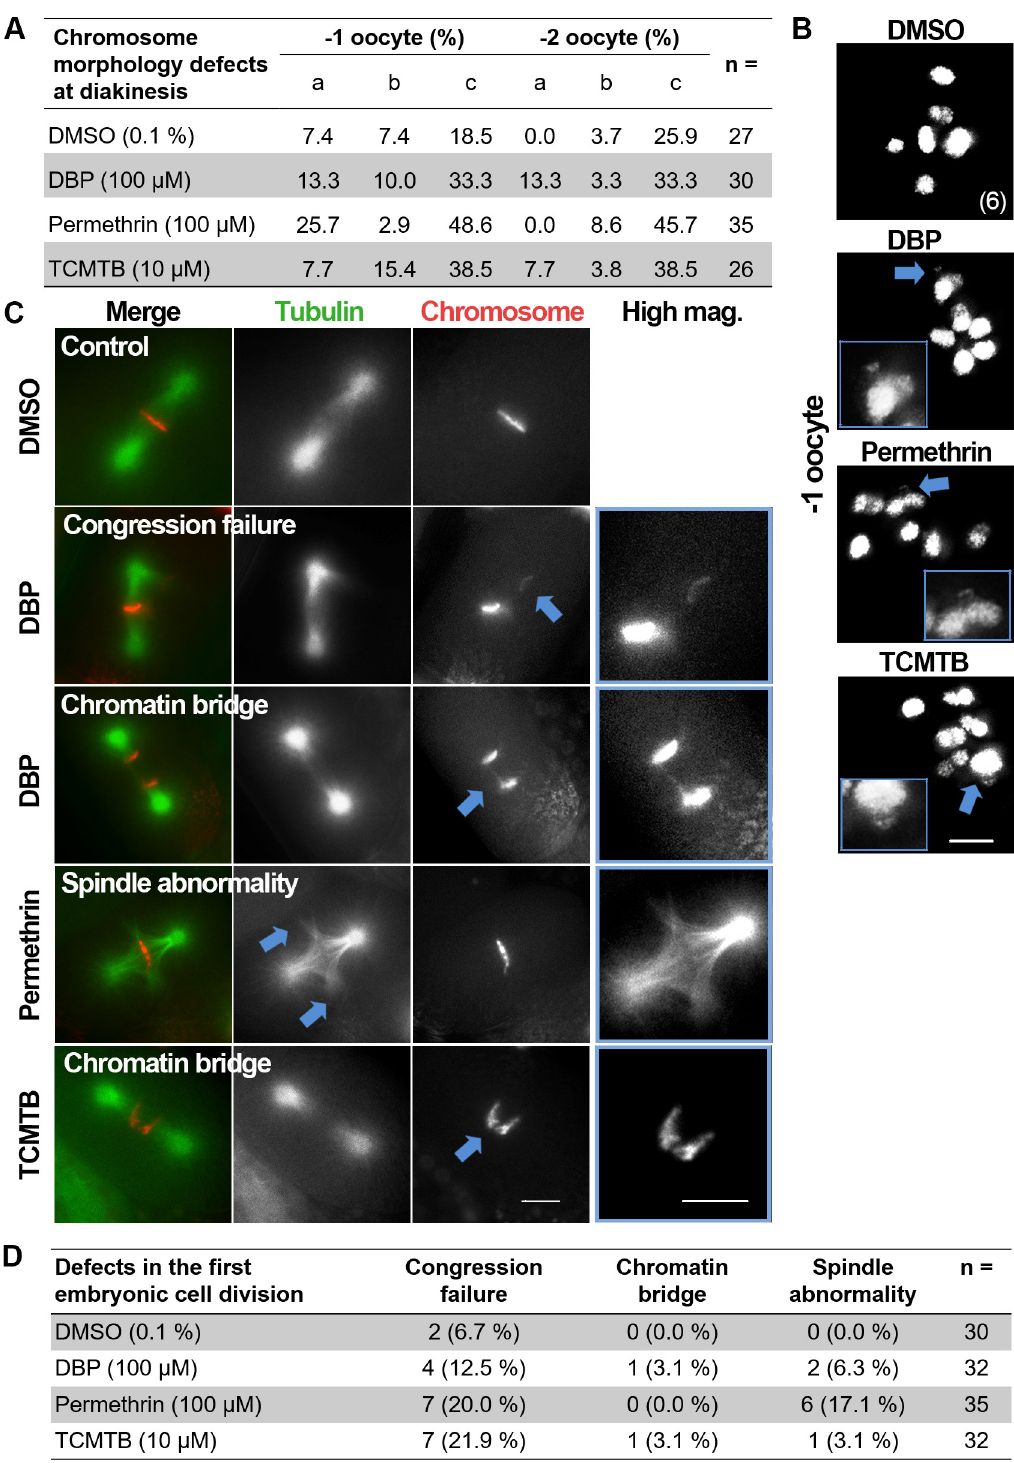
Fig 5. Chemical exposures lead to defects at diakinesis and the first embryonic cell division. (A) Quantification of the chromosome morphology defects observed in diakinesis (-1 and -2 oocytes). a: chromosome fragments, b: chromatin bridges, c: frayed chromosomes, n = total number of oocytes scored. (B) High resolution images of oocytes at diakinesis positioned right before the spermatheca (-1 oocyte). Six intact bivalents are observed in control. In contrast, frayed chromosomes, chromosome fragments and chromosome bridges (arrows and magnified in insets) are observed at higher levels in the germlines of